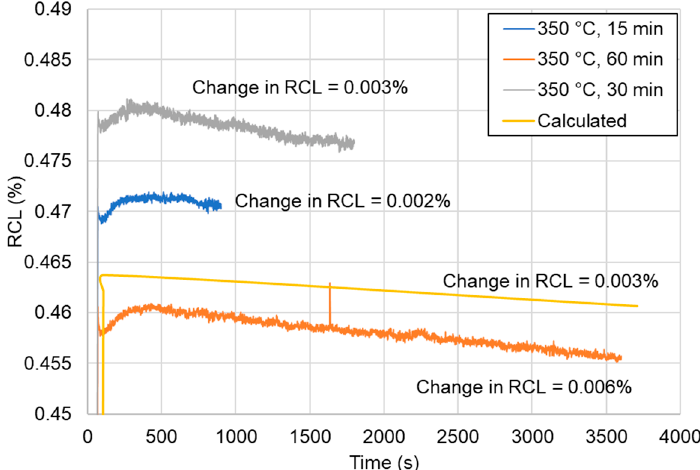
Figure 4. Tempering progress according to the dilatometric results and the JMatPro simulation.